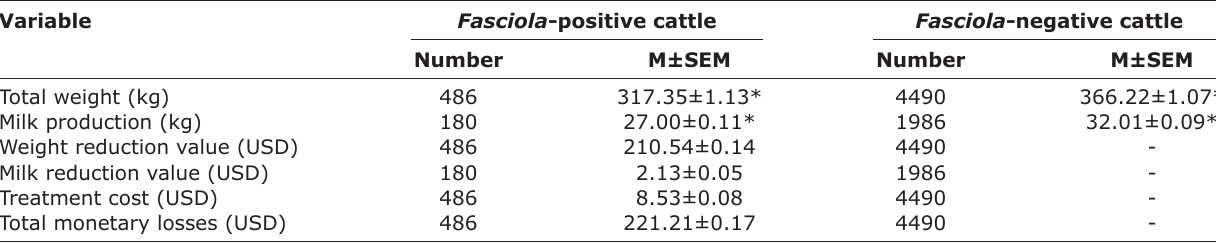
Table-5: Economic effects of bovine fascioliasis in the Nile Delta region of Egypt.